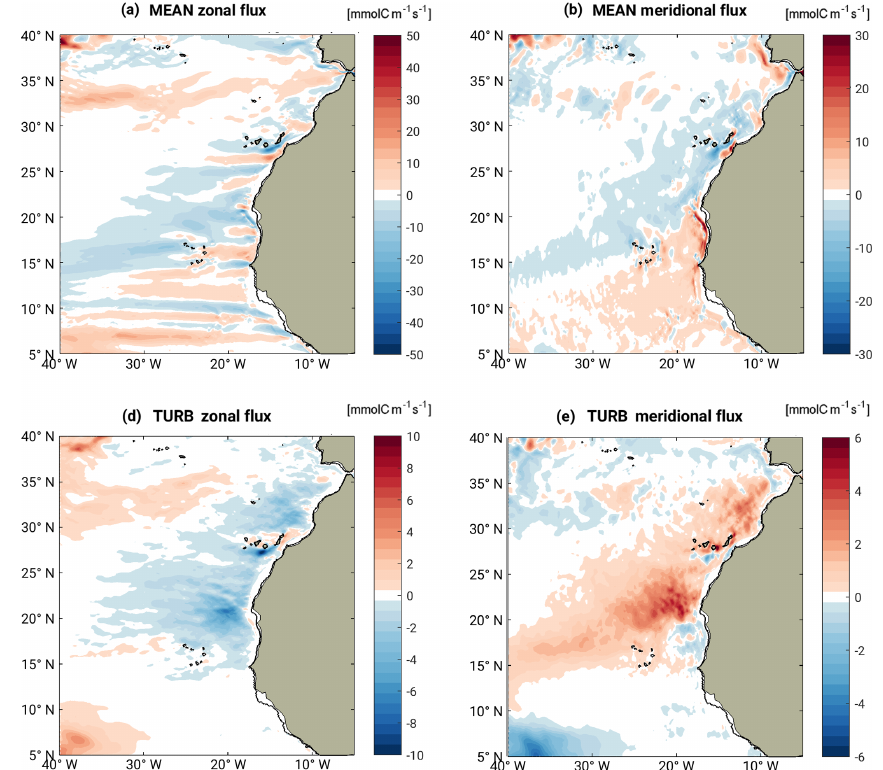
Figure B6. Reynolds decomposition of the lateral and vertical advective fluxes of C org below 100m into their average mean (cid:104) u C org (cid:105) and average turbulent (cid:104) u (cid:48) C org (cid:48) (cid:105) components, as defined in the methods section. Fluxes integrated from 100m depth to the bottom of the water column. Color-scale corresponding to those of Fig. 5 for a better comparison.